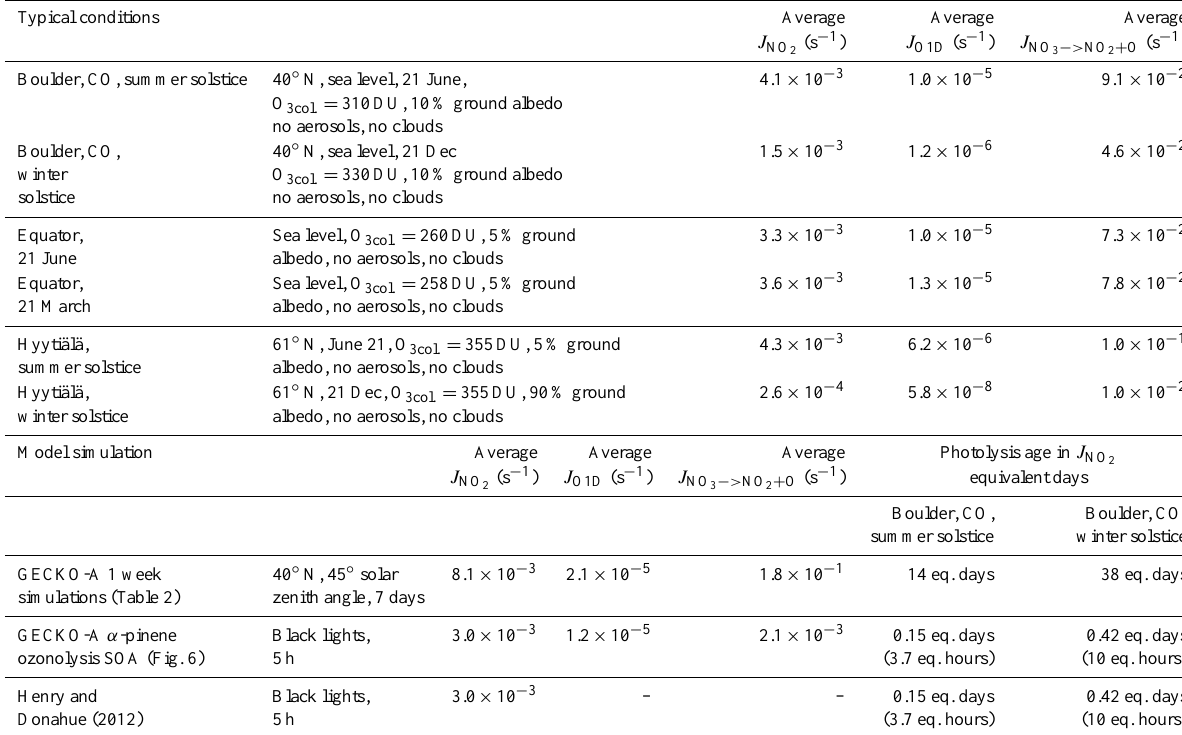
Table 1. Photolysis rate coefficients and photolytic lifetimes for typical atmospheric conditions and for our simulations. Typical ozone overhead values are used at different locations based on Total Ozone Mapping Spectrometer data (http://disc.sci.gsfc.nasa.gov/acdisc/TOMS). Typical